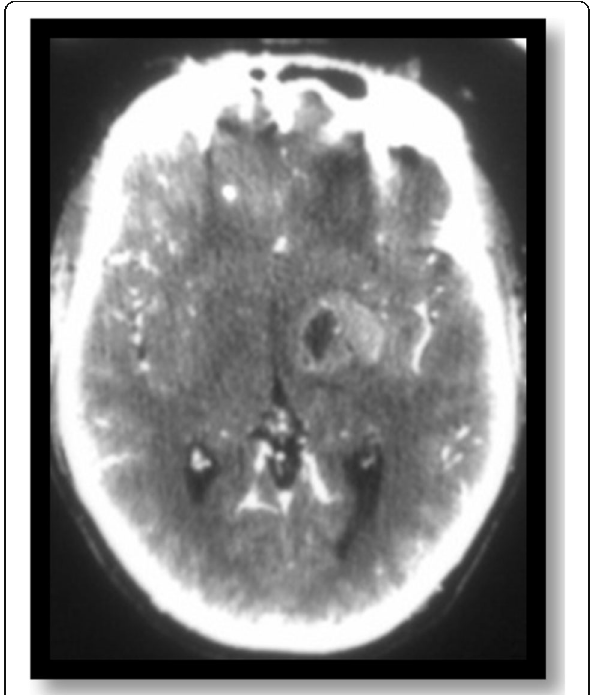
Fig. 3 Stereotactic CT for left thalamic pilocytic